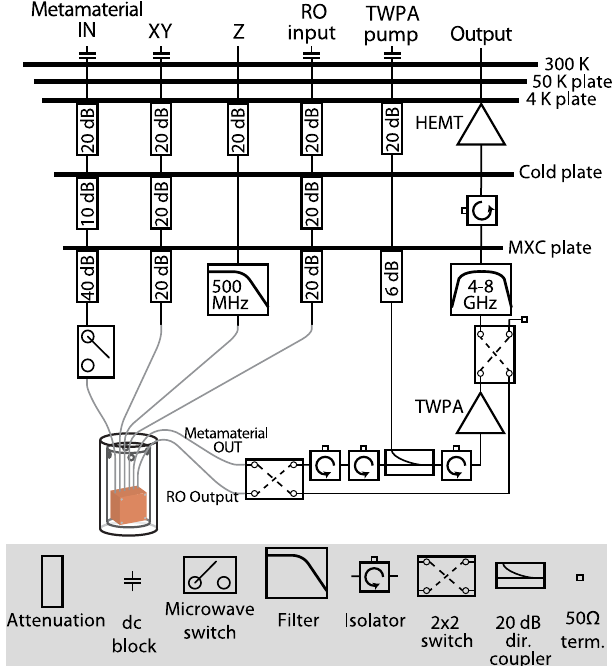
FIG. 5. Schematic of the measurement chain inside the dilution refrigerator. See Appendix text for further details ( “ dir ” is shorthand for “ directional ” , and “ term ” is shorthand for “ termi- nation ” ). See Fig. 2 for electrical connections at the